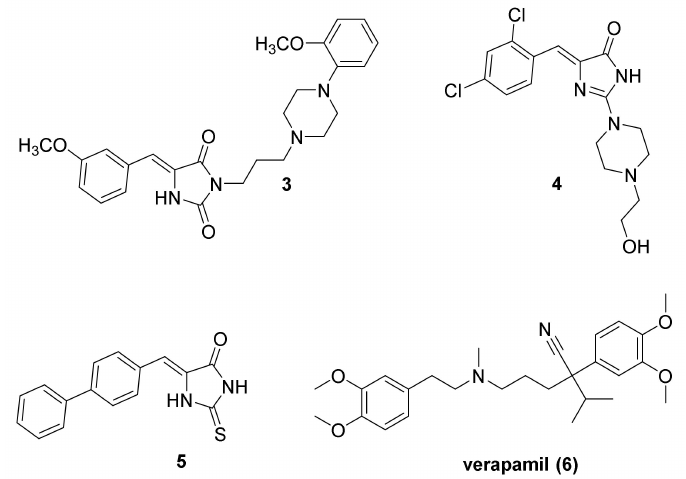
Figure 2. Previously found (thio)hydantoin derivatives able to modulate ABCB1 in cancer cells ( 3 – 5 ) and the reference modulator, verapamil ( 6 )